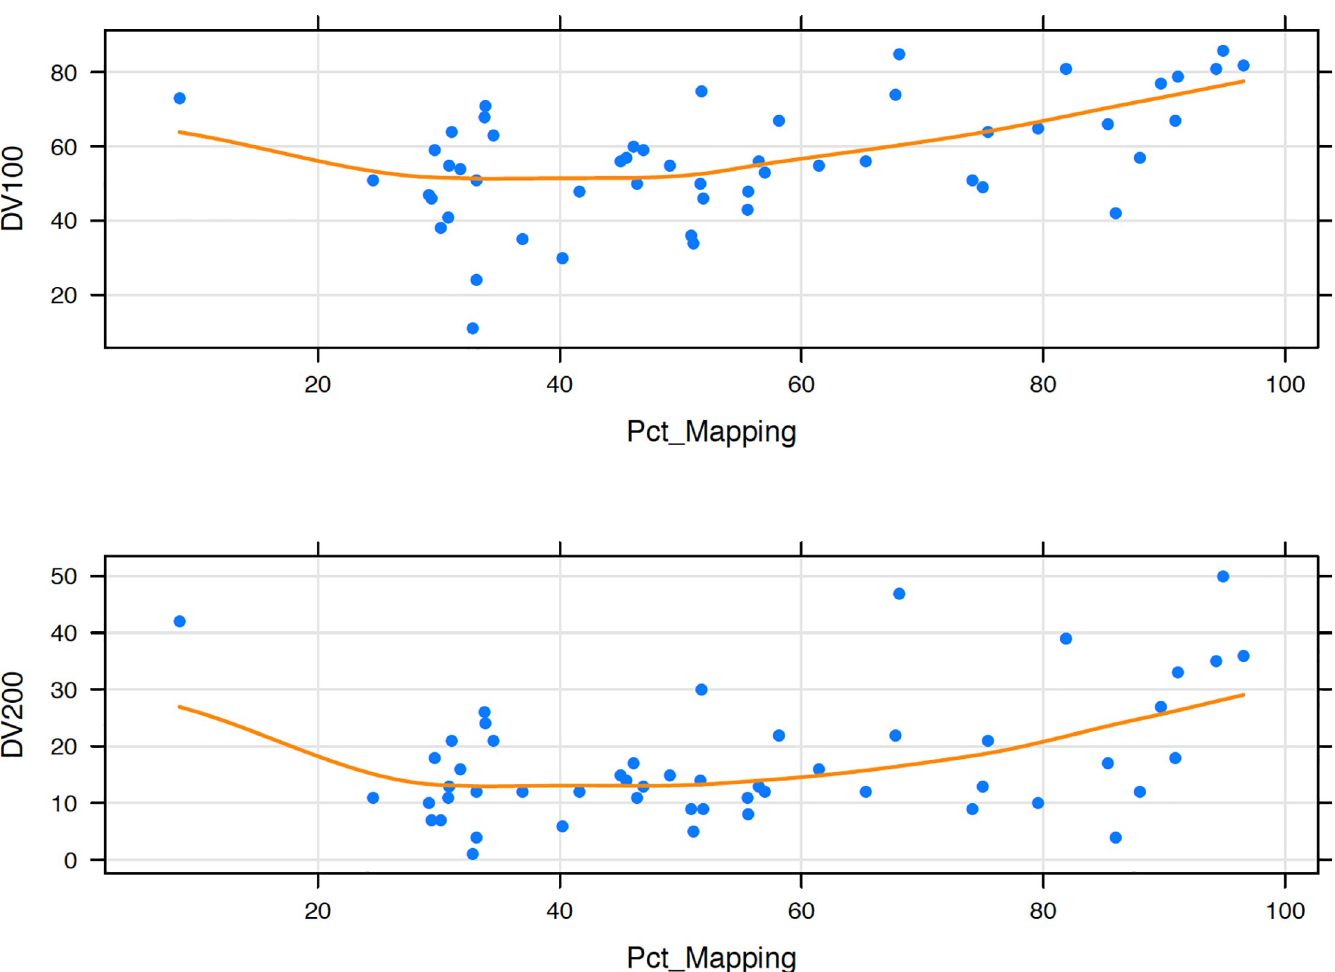
Fig 3. Percent mapped RNAs by DV 100 and DV 200 values. Plots showing percent mapped RNAs for samples with varying degrees of fragmentation, as depicted by fragment distribution values (DV 100 (top plot) and DV 200 (lower plot)). Every blue dot represents an individual sample, and the orange line represents the curve of best fit.